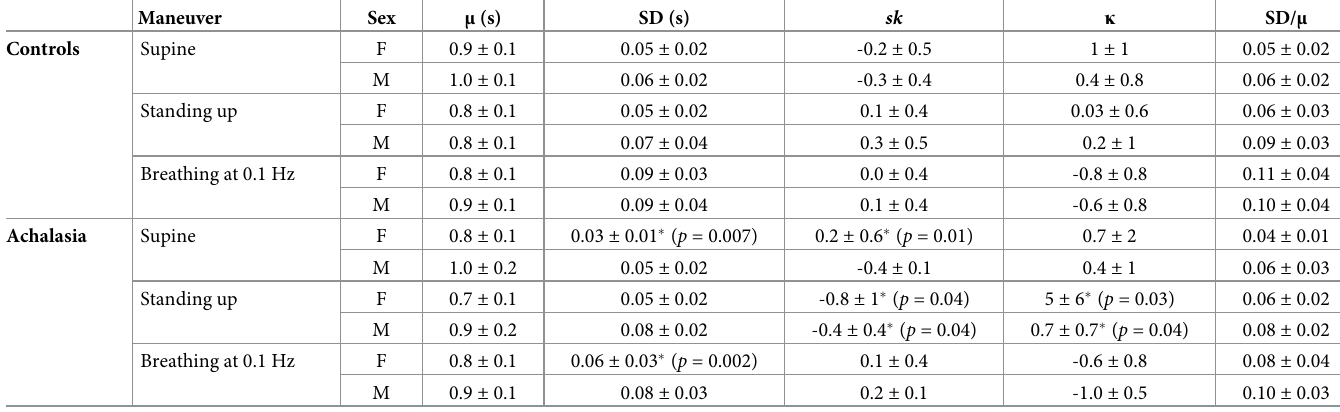
Average and standard deviations of our controls agree with previous publications [73]. Histo- grams of the detrended IBI records for a typical female and male control, female (F) and male (M) achalasia patients, all with similar BMI and age, for supine position, standing up position, and under controlled breathing at 0.1 Hz test are plotted in Fig 2, while Fig 3 shows the SBP. Table 1. Heart interbeat interval in the time